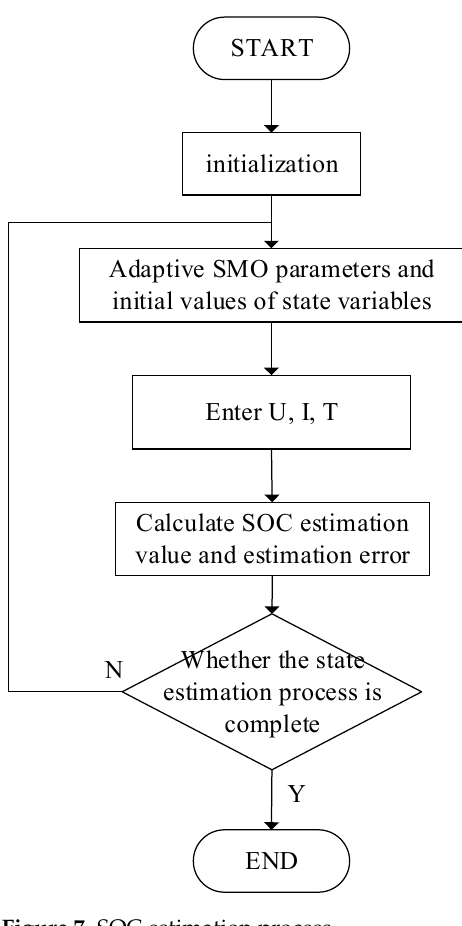
Figure 7. SOC estimation process.